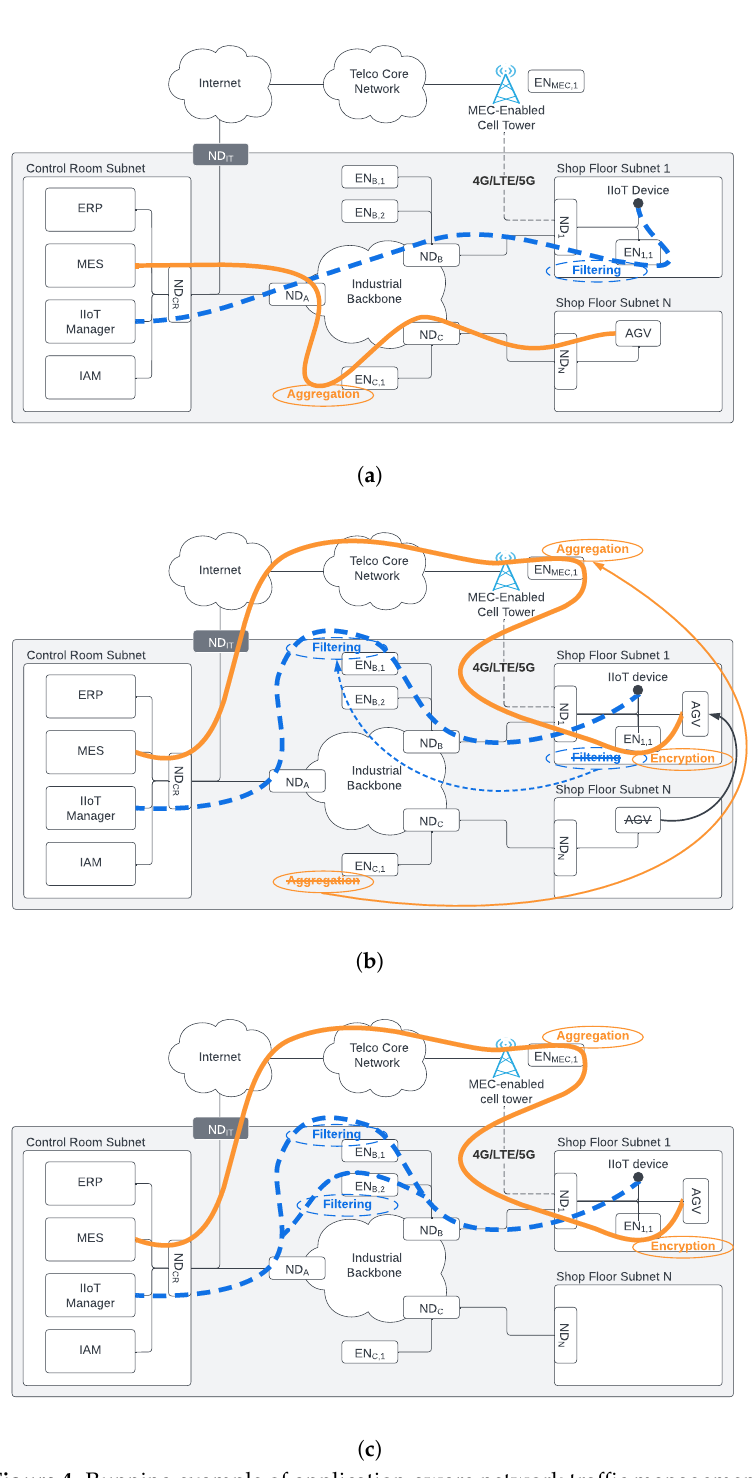
Figure 4. Running example of application-aware network traffic management in a MEC-integrated industrial environment. ( a ) Initially, the flows produced by the AGV (solid orange line) and IIoT device (dashed blue line) are processed on-premises. ( b ) Subsequently, the AGV changes to the shop floor subnet. This triggers the IAM, which decides to reconfigure the environment by also taking advantage of the MEC. ( c ) Because the flow produced by the IIoT device traverses a resource-rich cluster zone, additional replicas of the data filtering module are scaled out dynamically to better fit the